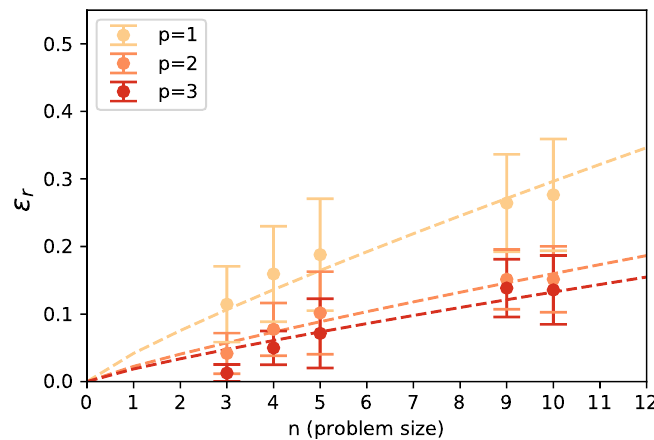
Figure 2: Comparison of converged final relative error (cid:34) (median), for p ∈ { 1,2,3 } , r as a function of problem size n ∈ { 3,4,5,9,10 } . Simulations performed with access to the exact wave form (statevector QVM) done on 100 problem instances per n with an optimization budget of 200 iterations for p ∈ { 1,2 } and 400 iterations for p = 3. The dashed curves in the plot are fitted to the experimental data. The information presented in this figure is the output of experiments described in Section